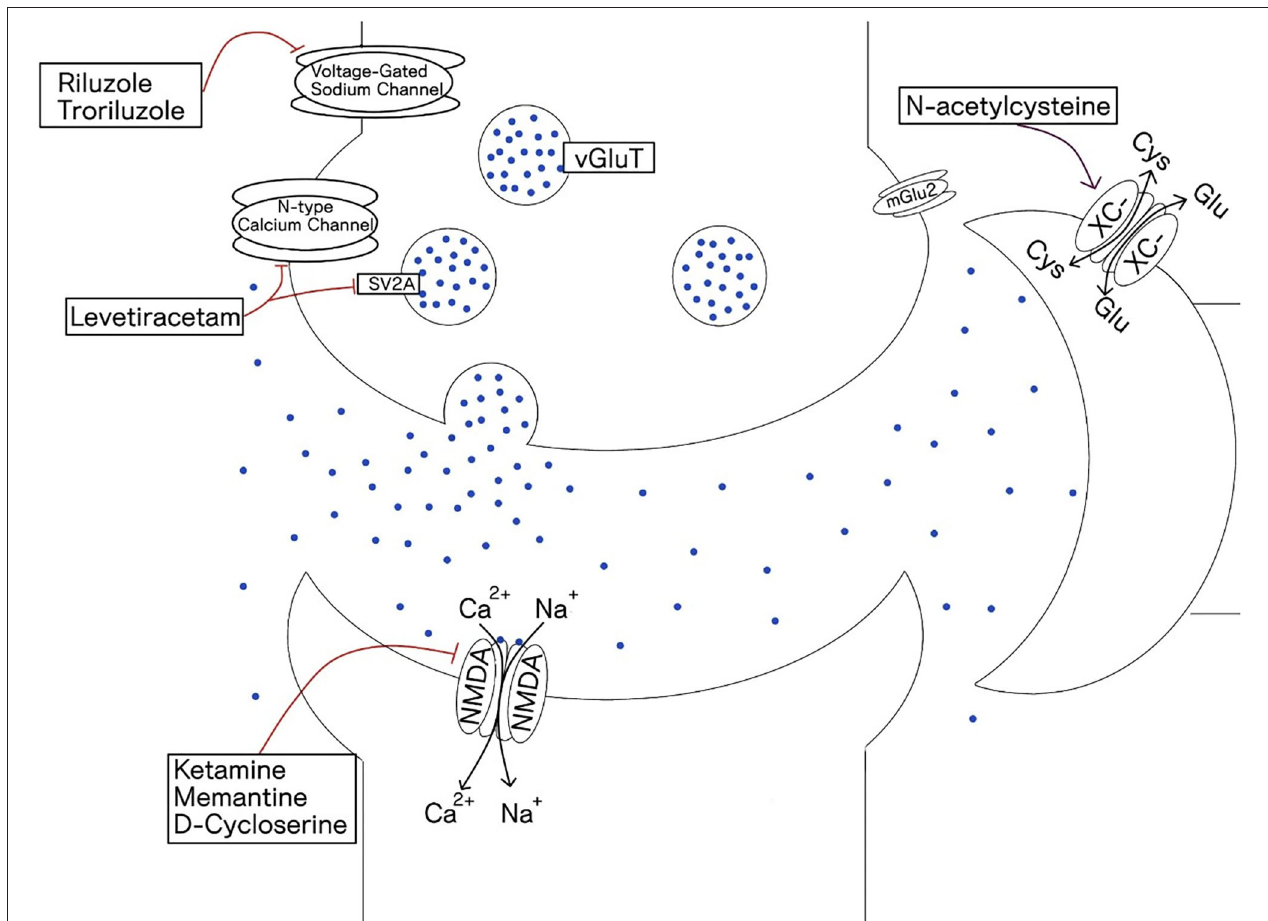
FIGURE 2 | Depicts glutaminergic synapse and the receptors that are the site of action of glutaminergic drugs. Glutamate is packed into vesicles by vesicular glutamate transporter (vGluT). It binds to both ionotropic receptors and metabotropic receptors. Glial cells play a primary role in glutamate reuptake thus terminating the glutamate synaptic signal. Steady-state extra synaptic glutamate levels are also regulated by the glial cystine-glutamate antiporter